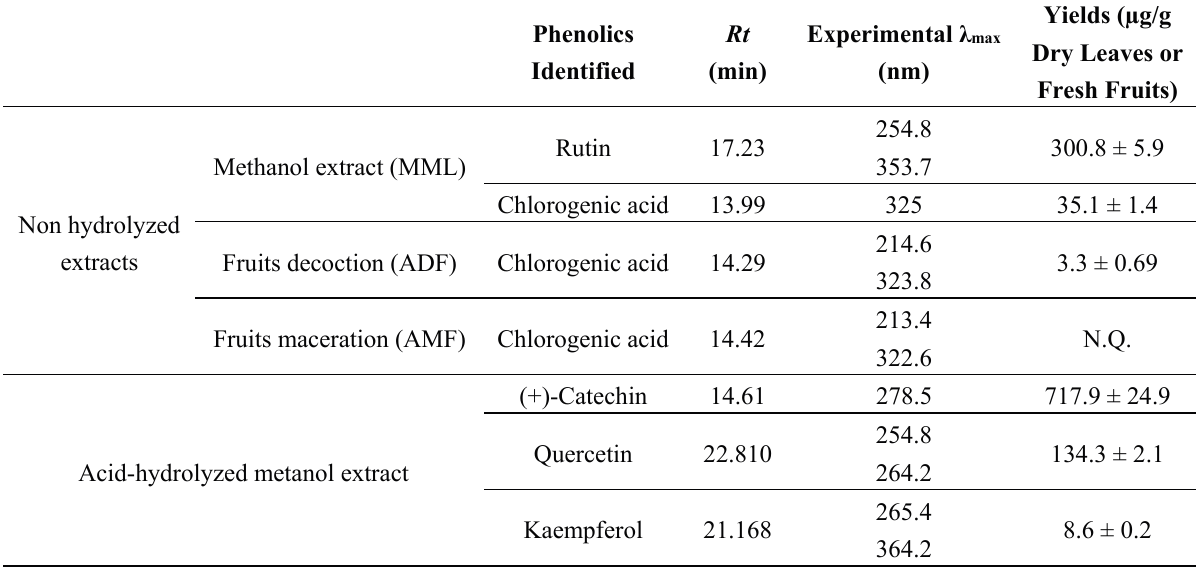
Yields (µg/g Phenolics Rt Experimental λ max Dry Leaves or (nm) Identified (min) Fresh Fruits)